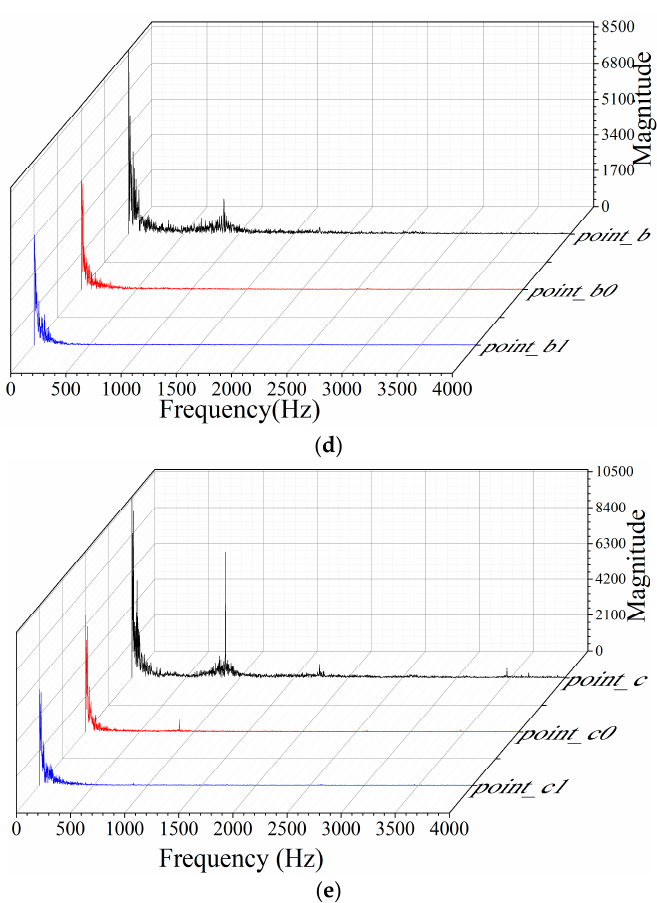
Figure 25. Spectrum characteristics of monitoring points on the Z = 0 m plane. (a) at point a, b, c, and d, (b) at point b1, c1, and d1 , (c) at point c0, and b0,(d) at point b,b0,and b1,(e) at point c,c0, and c1